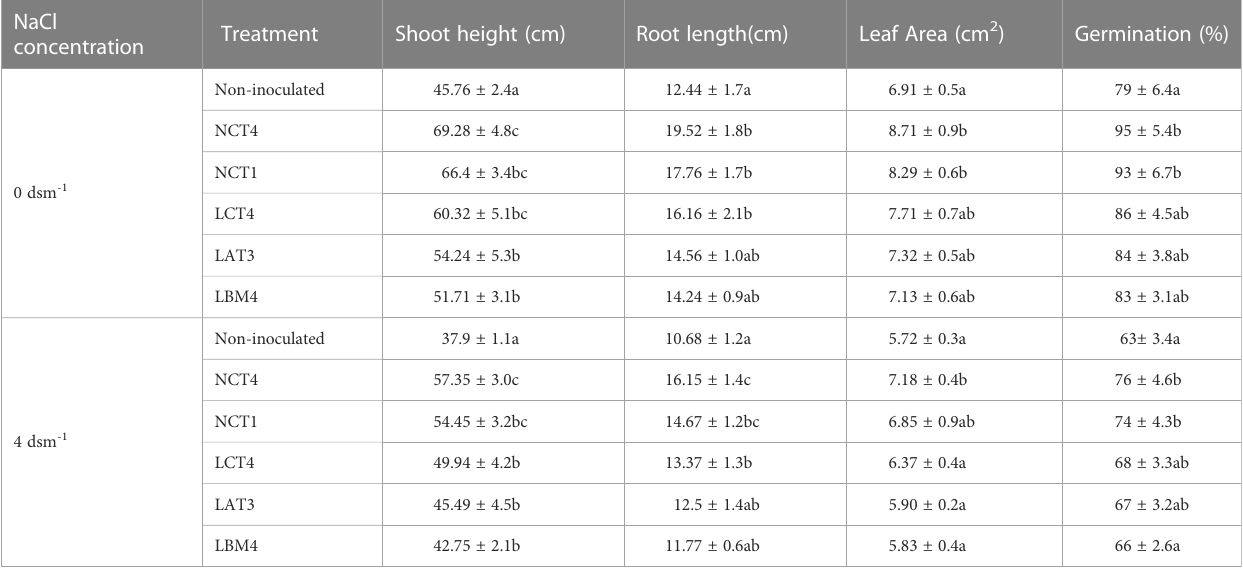
TABLE 2 Effects of plant growth-promoting rhizobacteria on the shoot height, root length, leaf area and germination % of tomato plants under saline conditions. NaCl Treatment Shoot height (cm) Root length(cm) Leaf Area (cm 2 ) Germination (%) concentration